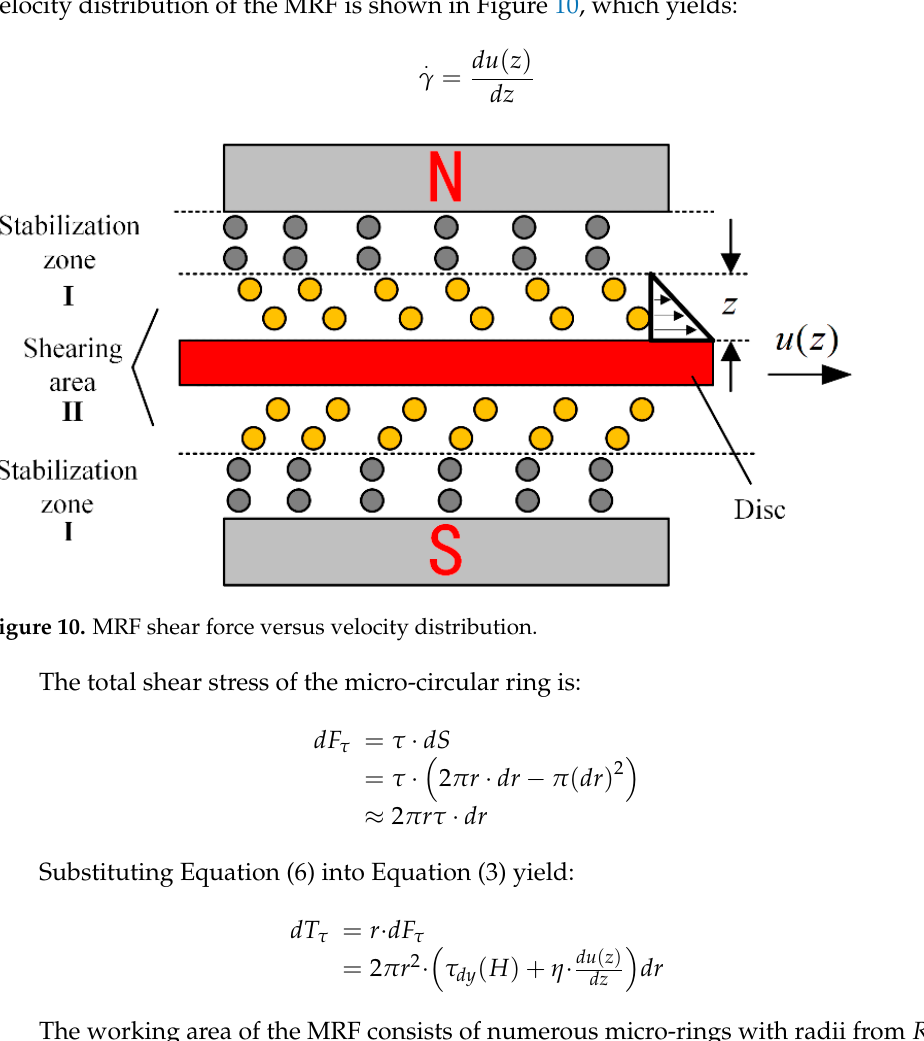
( b ) Figure 9. ( a ) Magnetorheological fl uid area. ( b ) Upper view of the MRF region generating resistance. The inner and outer longitudes of the ring are 𝑅 (cid:2869) and 𝑅 (cid:2870) , respectively. The working region of the MRF is abstracted as a micro-ring of width 𝑑𝑟 . When 𝑑𝑟 is assumed to be small enough, its radius is approximated as 𝑟 . Then, the torque of the shear force of this micro-ring is: